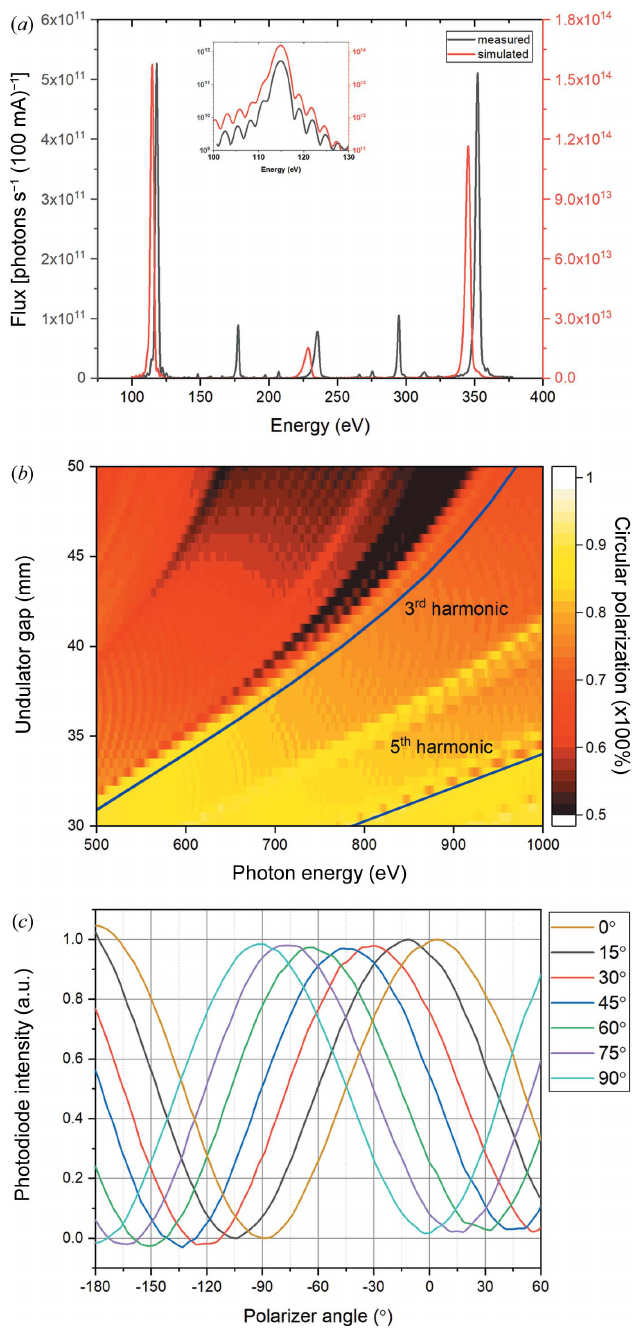
Figure 1 ( a ) Simulated and measured undulator spectra in planar mode for an undulator gap of 30 mm. The beamline opening is 0.1 mrad. The monochromator grating features 1221 lines mm (cid:3) 1 . The inset shows the agreement between the simulated and measured spectra for the first harmonics at 115 eV (logarithmic scale on the intensity axis); the small energy shift has been corrected. The experimental undulator spectrum was measured right after the exit slit of the beamline. ( b ) Calculated map of the undulator spectra showing the degree of circular polarization of the photon beam at the fixed phase of 14 mm. The locations of the third and fifth harmonics are indicated by the blue curves. ( c ) Reflected X-ray intensities versus azimuth angles of the multilayer analyzer in the polarimeter when the undulator, i.e. the gap and phase, were configured to several simulated polarization angles in the inclined mode. The photon energy is 708 eV, and 0 (cid:5) (90 (cid:5) ) means the polarization of the X-rays is linearly horizontal